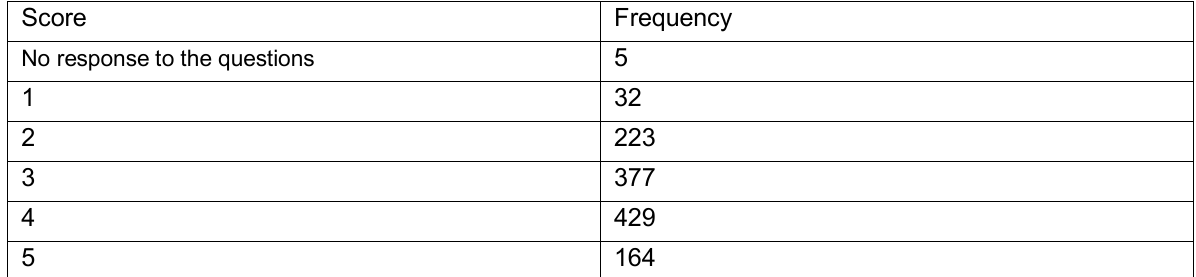
Table 3: Frequency Distribution of The Financial Attitude Scores (Rounded Scores Are Used) Score Frequency No response to the questions